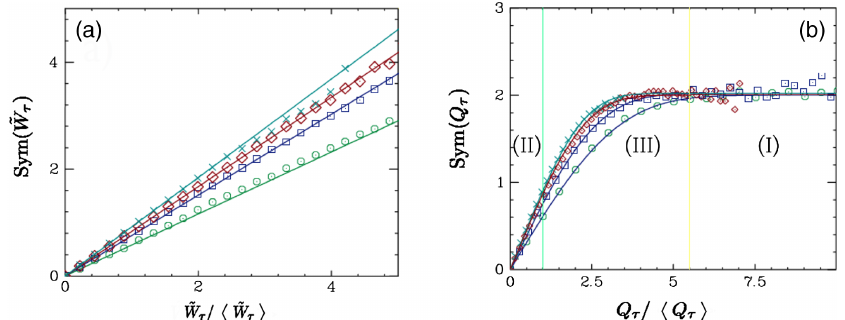
FIG. 3. Sinusoidal forcing. Symmetry functions for SSFT. (a) Symmetry functions Sym ð w τ Þ plotted as a function of w τ for various n : n ¼ 7 (circle), n ¼ 15 (square), n ¼ 25 (diamond), and n ¼ 50 (times). For all n , the dependence of Sym ð w τ Þ on w τ is linear, with slope Σ ð τ Þ . (b) Symmetry functions Sym ð q w q τ < 1 . Continuous lines are theoretical